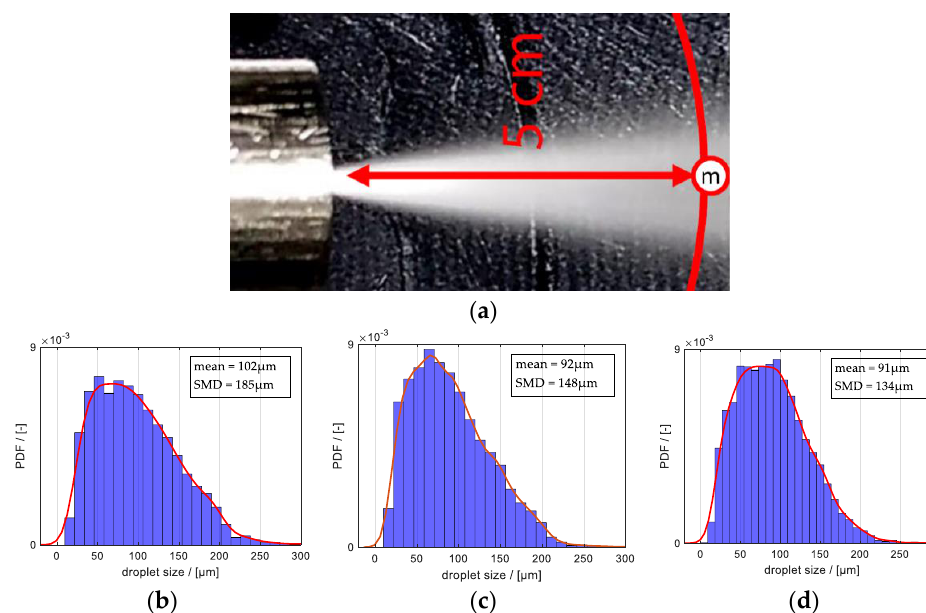
Figure 8. Droplet sizing of a prototype pre-design fluidic injector operated with Diesel No.2 at ( b ) 5 bar(g), ( c ) 10 bar(g), and ( d ) 15 bar(g) feed pressure in quiescent air, ( a ) gives an overview of the measurement position indicated with letter m with respect to the nozzle exit, ( b - d ) show droplet diameter distribution at measurement position m in terms of a probability density function (PDF).